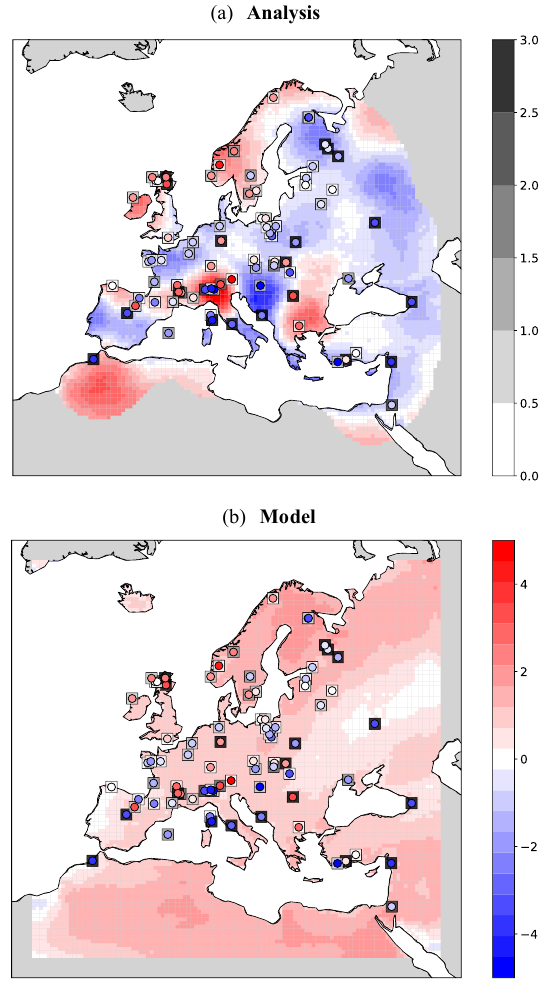
Figure 17. DA results of T2M during summer at 6KBP using weighted arithmetic mean by standard errors: (a) analysis values along with the testing observations (circles) and their standard error (squares). Values with an error covariance of analysis greater than 0.9 are masked out from analysis and (b) the model